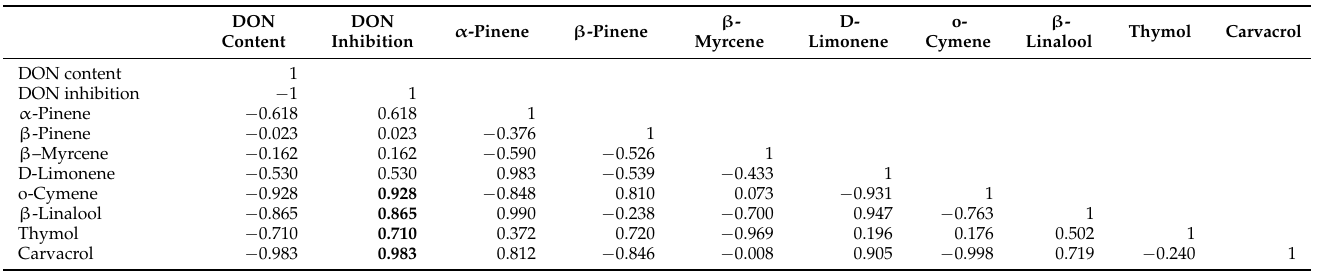
Table 5. Pearson correlation coefficient matrix for DON content and DON inhibition (%) and the chemical composition of EO mixtures (TO, TC,